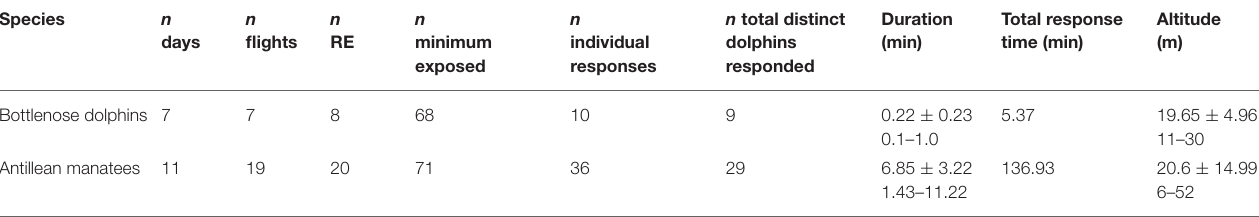
TABLE 4 | Characteristics of bottlenose dolphins and Antillean manatee responses to small unmanned aerial systems.